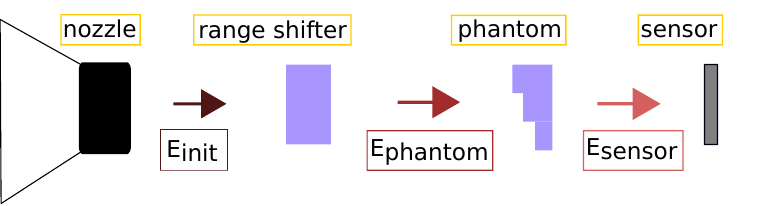
Figure 2. Sketch to illustrate the different stages of the proton energy: the proton energy delivered by the accelerator E init ; the proton energy behind the variable thickness of RW3 slabs E phantom ; the proton energy incident on the silicon sensor E sensor .